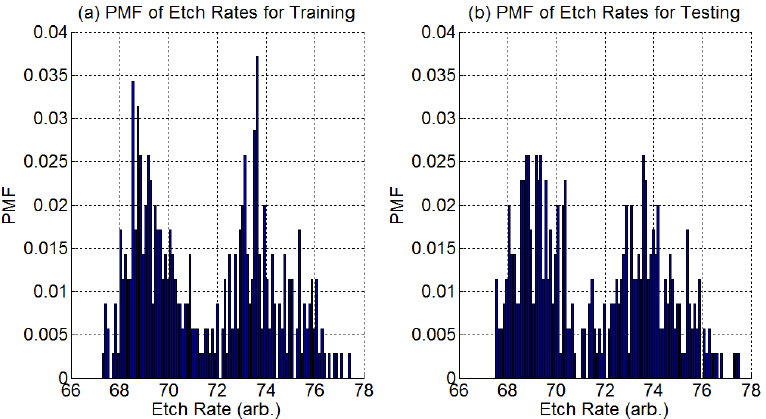
Figure 4. Estimated Probability Mass Function (PMF) of etch rates for ( a ) training group and ( b ) testing